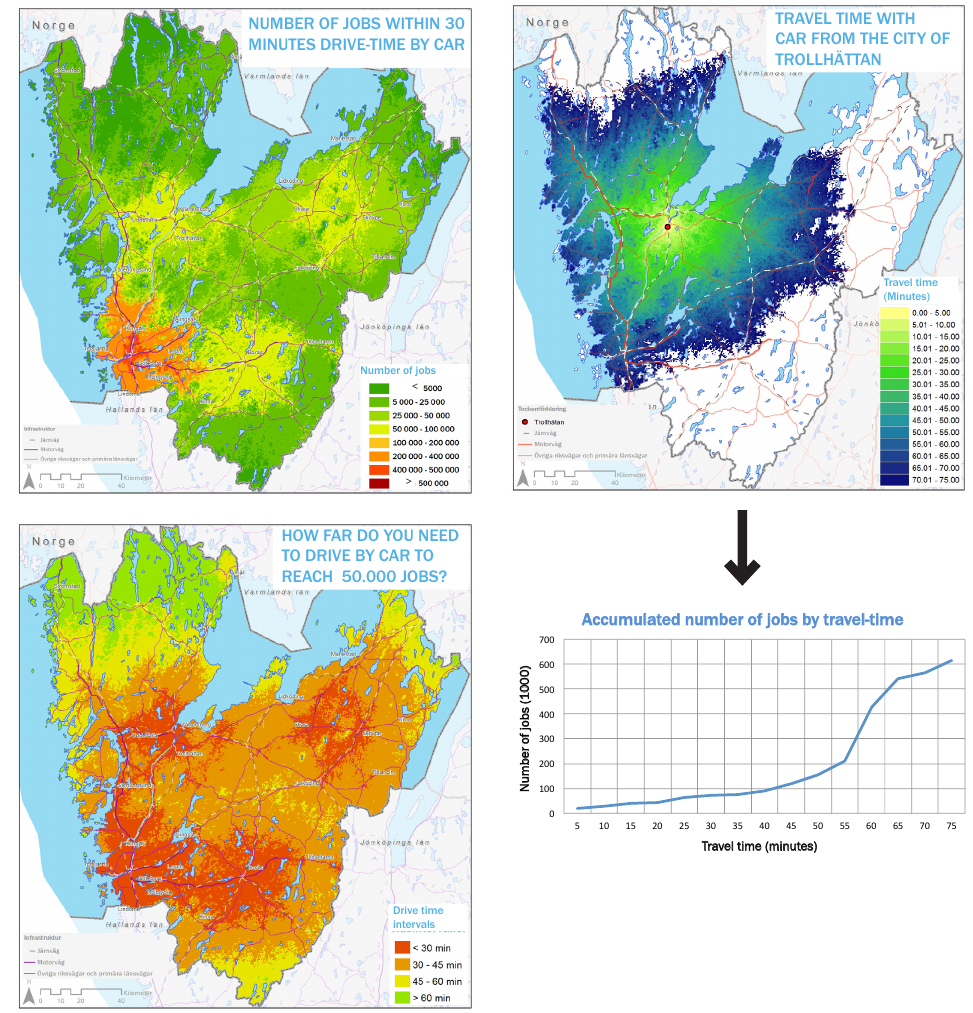
Figure 2: Illustrations of different accessibility measures using the same data: fixed cost (top left), constant target points (bottom left), constant starting point (top right), and potential jobs by travel time (bottom